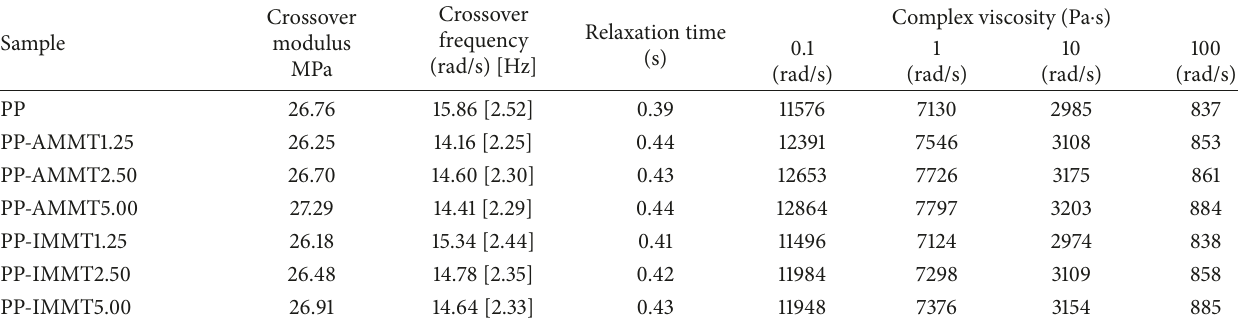
Table 2: Rheological parameters of PP and its